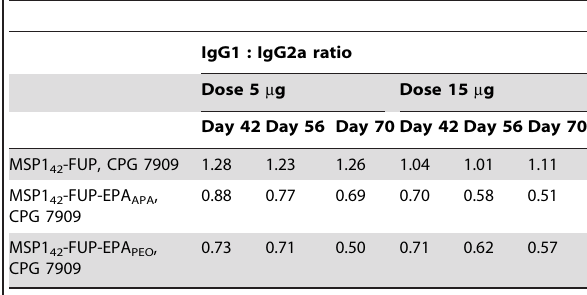
Table 3. IgG subclass analysis of MSP1 42 -FUP-specific mouse antibodies elicited by the formulations with CPG